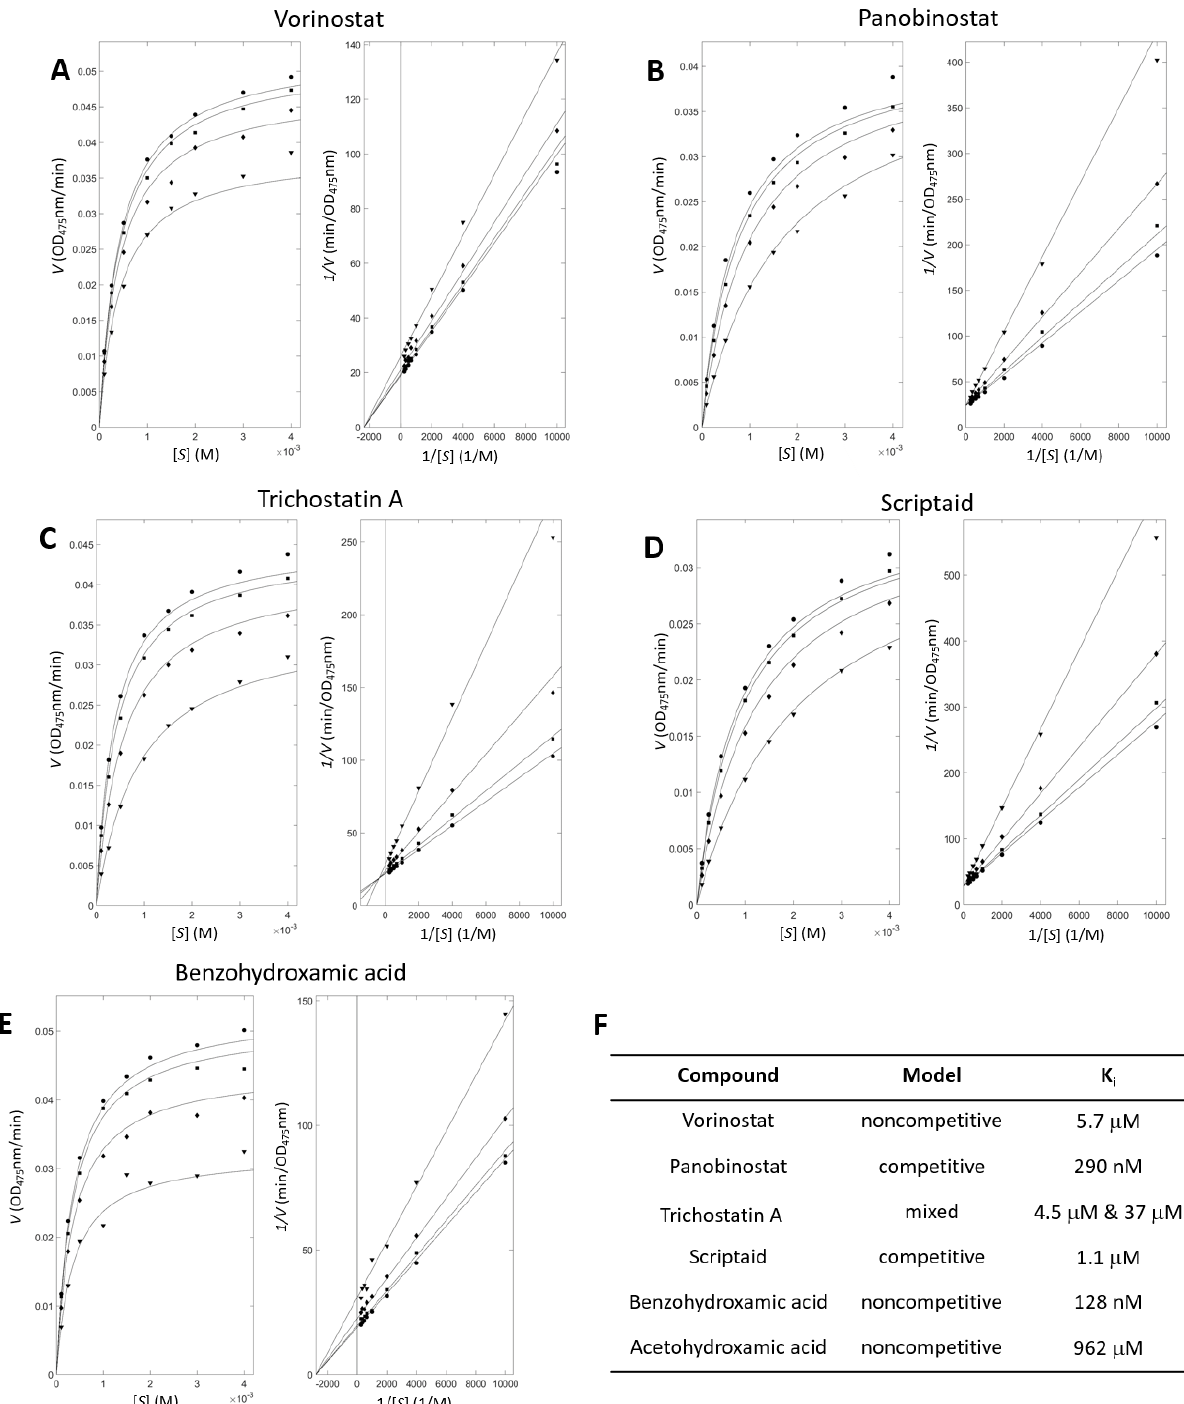
Figure 4. Enzyme-inhibitory kinetics with tyrosinase and inhibitors. ( A E ) Left and right panels show Michaelis–Menten and Lineweaver–Burk plots, respectively, for the five representative inhibitors: ●, ■ , and ▼ represent inhibitor concentrations of 100, 250, 750, and 2250 nM for vorinotstat; 20, 50, 150, and 450 nM for panobinostat; 0.5, 1.2, 3.6, and 10.8 μM for trichostatin A; 100, 200, 600, and 1800 nM for scriptaid; and 5, 10, 30, and 90 nM for benzohydroxamic acid, respectively. ( F ) Kinetics models and simulated inhibitory constants for each inhibitor. The first and second values for trichostatin A mean the inhibitory constants for apo and holo states,